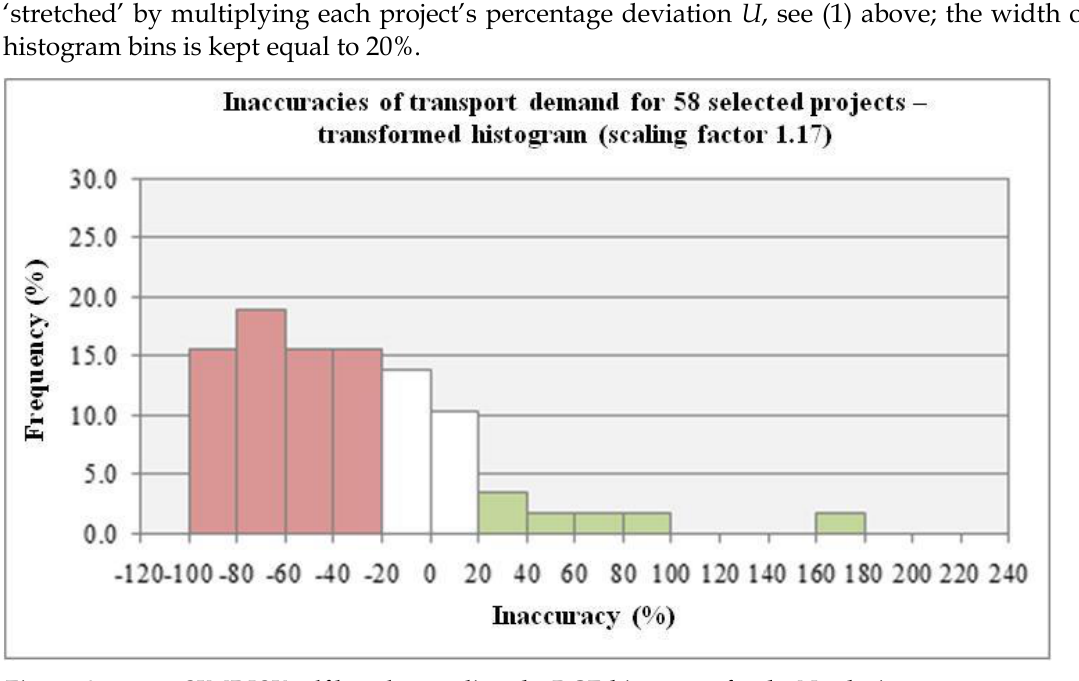
Figure 6. SIMRISK pdf based on scaling the RCF-histogram for the Nuuk airport